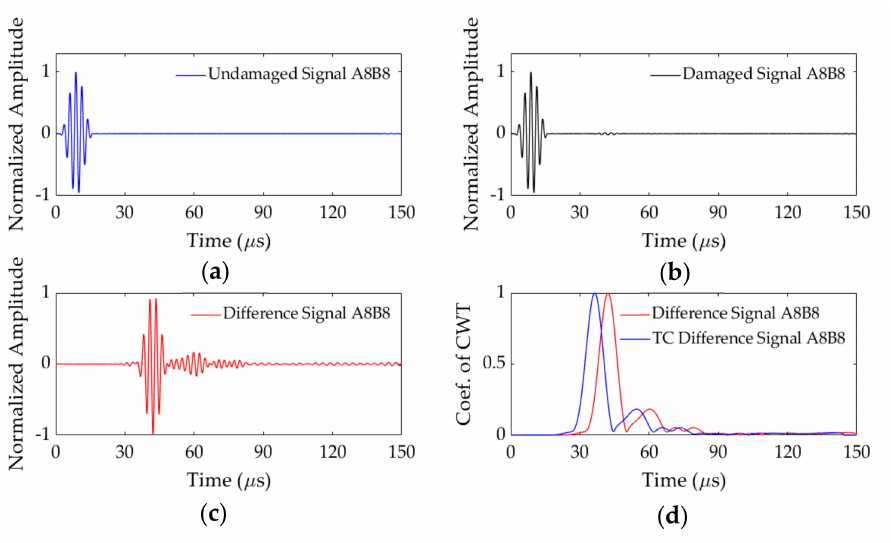
Figure 13. Signals for sensing path A8B8: ( a ) undamaged; ( b ) damaged; ( c ) di ff erence; ( d ) coe ffi cient of CWT with and without time compensation.